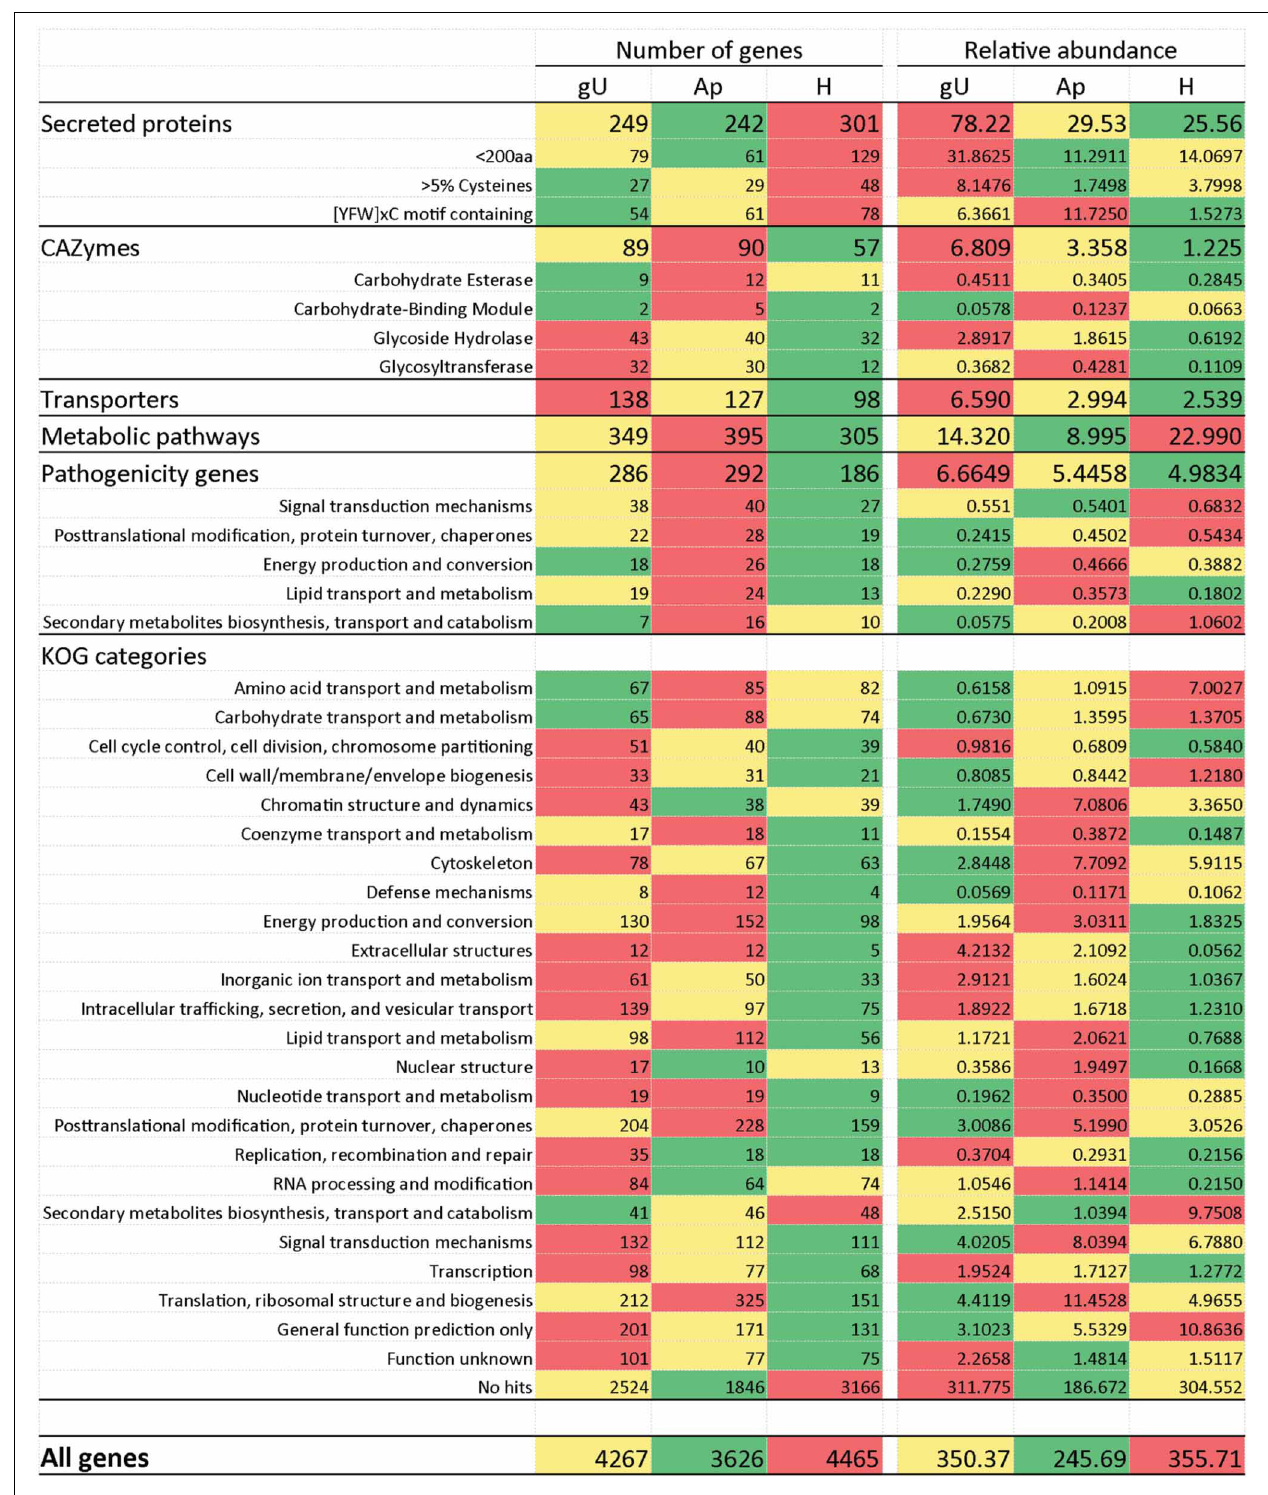
FIGURE 2 | Heatmaps of the number of genes and sum of their relative abundance values ( = number of transcripts/transcript length) in the three libraries (germinating urediniospores, gU; appressoria, Ap;